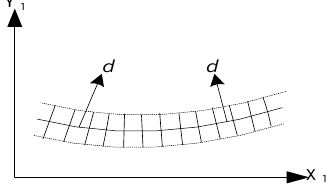
Fig.2 The segmentation of point